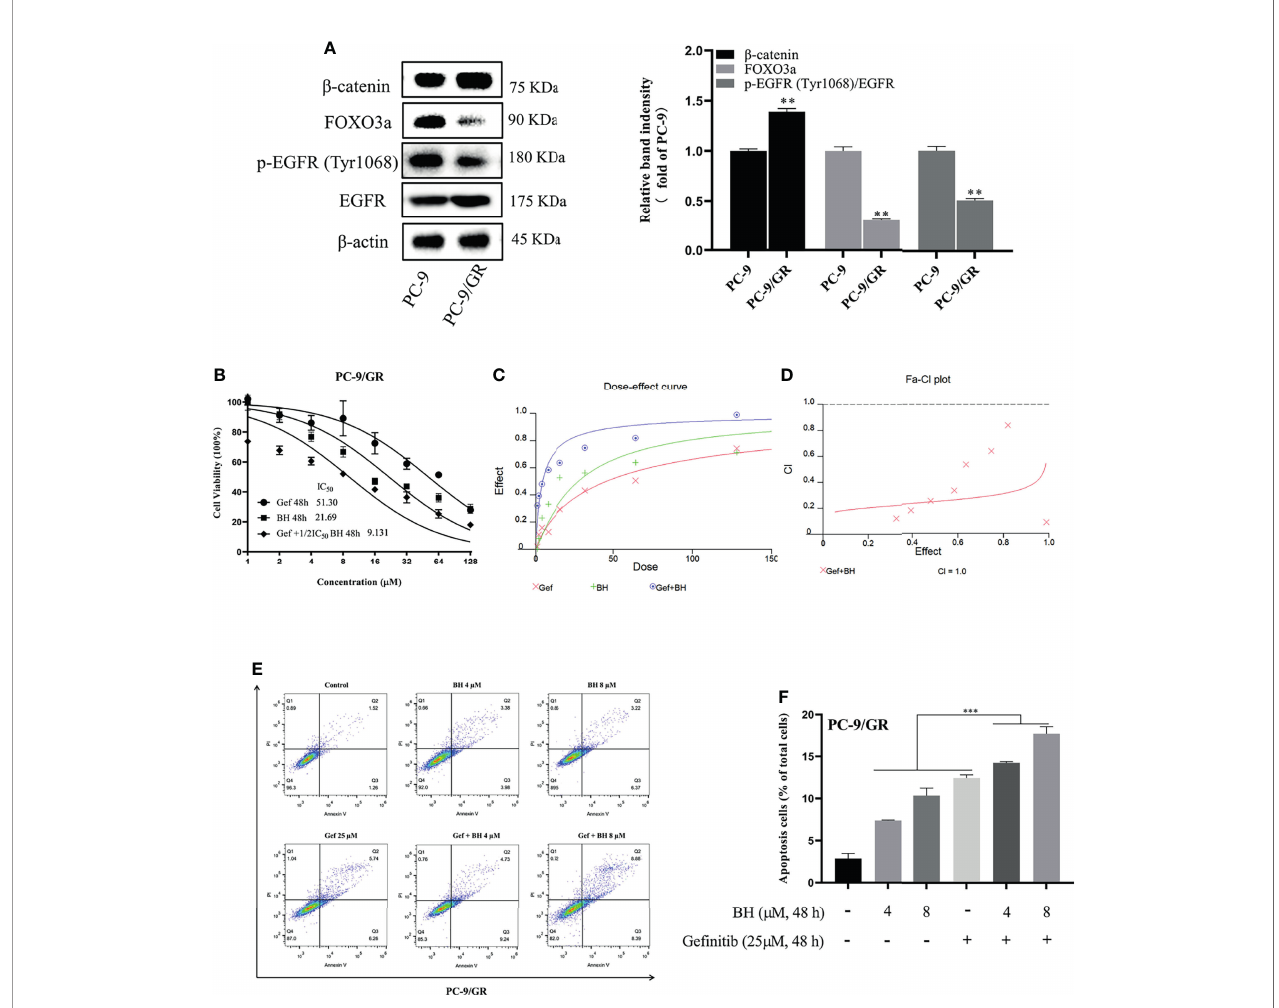
FIGURE 3 | BH signi fi cantly enhanced ge fi tinib sensitivity in vitro . (A) The different expressions of b -catenin, FOXO3a, p-EGFR (Tyr1068), and EGFR in PC-9 and PC-9/GR cells were measured by Western blot. (B) PC-9/GR cells were incubated with BH, ge fi tinib, and combination at the indicated concentrations for 48 h. (C, D) The combined action curve of ge fi tinib and BH and the synergistic effect index of drug combination in PC-9/GR cells (CI = 1 when the two drugs were superimposed, CI < 1 when the combination of drugs appeared synergistic effect, CI > 1 when antagonistic effect appeared). (E, F) Representative fl ow cytometry of PC-9/GR cells treated with ge fi tinib alone or combined with BH for 24 h. “ ** ” represents BH group vs. the Control group (**p < 0.01, ***p <